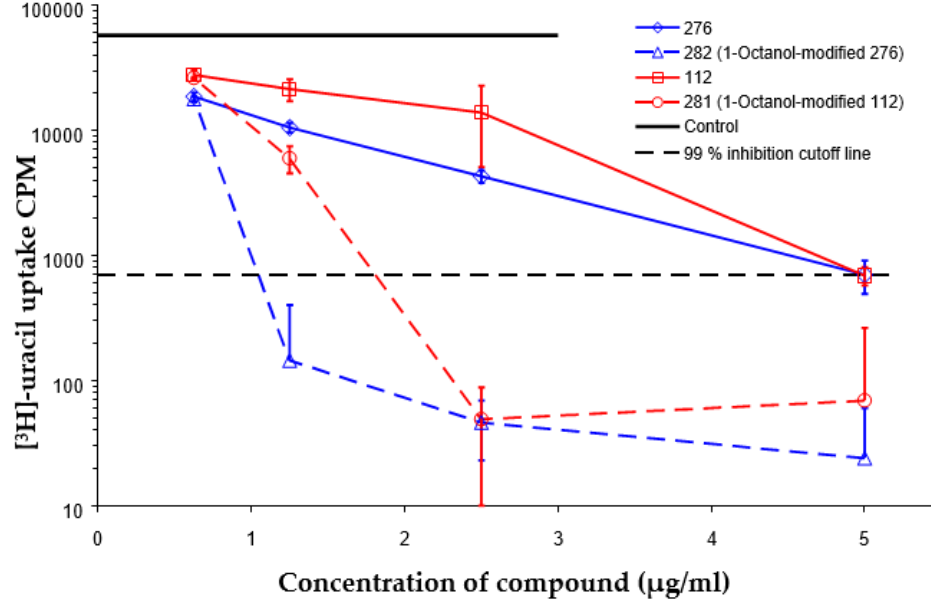
Figure 1. Inhibition of 3 [H]-uracil uptake by intracellular mycobacteria. Results are expressed as medium counts per minute (CPM ± SD) for triplets. Solid black line (control): the level of [ 3 H]-uracil uptake in the absence of compounds. Dashed line: the level of 99% inhibition compared to control samples. Table 2. Introduction of octyl residues improves performance of 3-triazeneindoles against intracellular M.